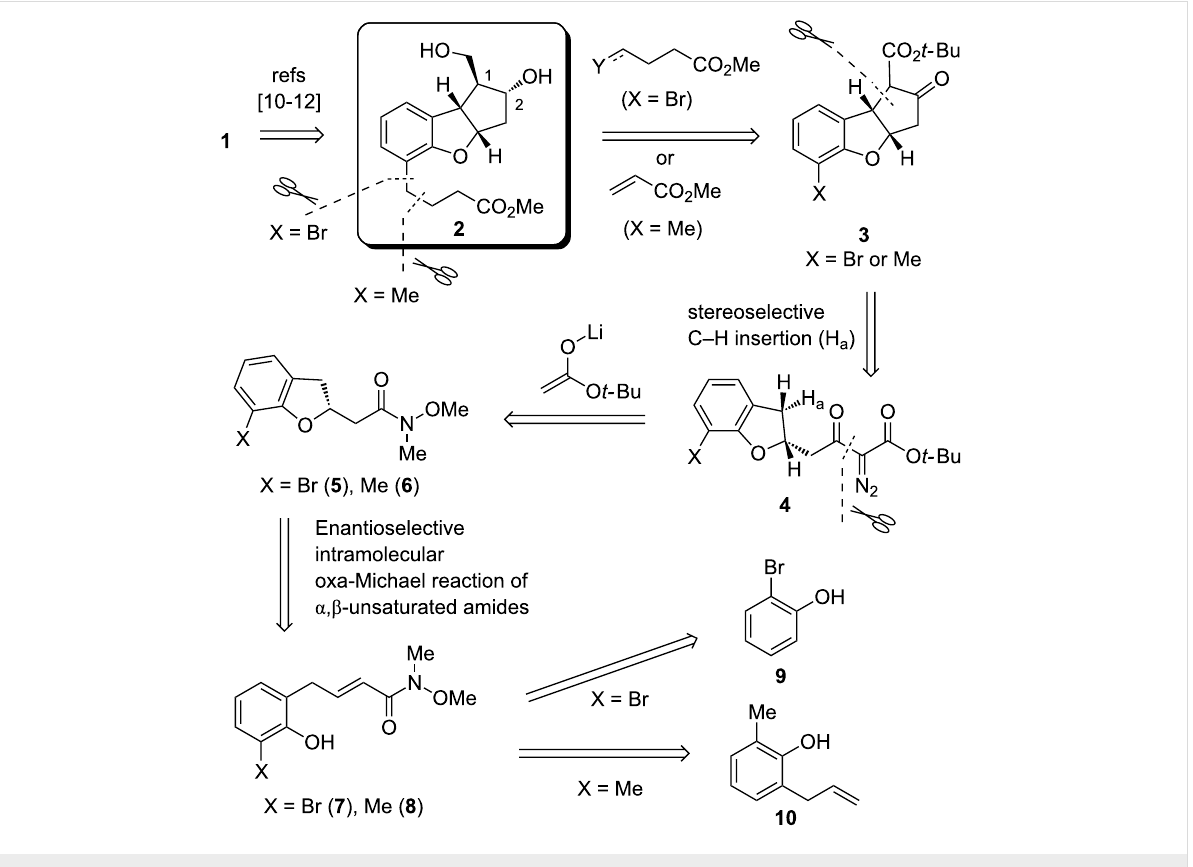
Scheme 1: Retrosynthetic analysis of beraprost ( 1